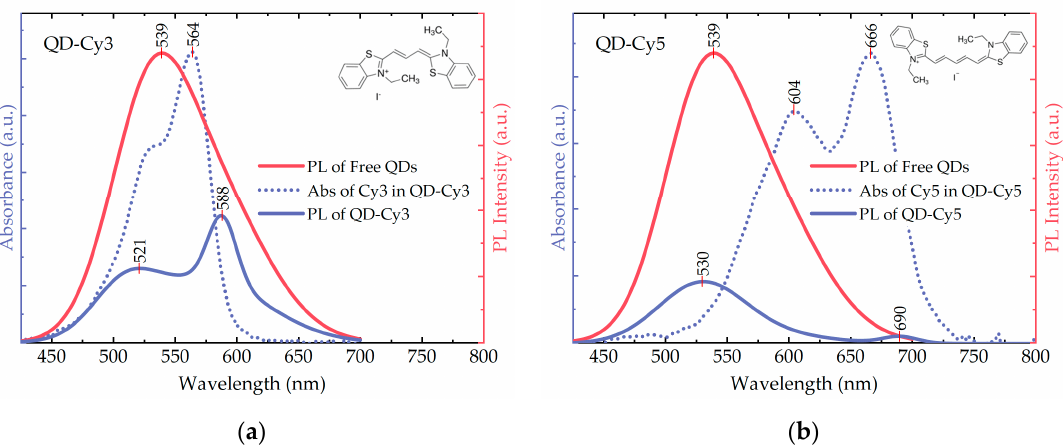
Figure 2. ( a )—QD-Cy3, ( b )—QD-Cy5. Spectral overlap of the free AIS/ZAIS/ZnS QD PL (red solid curves) with the dye absorbance in the respective QD-dye complexes (blue dotted curves). The dye absorbance was obtained by subtraction of the QD absorbance from the complex absorbance. Photoluminescence of the QD-dye complexes (blue solid curves) indicate the energy transfer from the QDs to the dyes (see text for the details). Insets: structural formulae of Cy3 ( a ) and Cy5 ( b ).